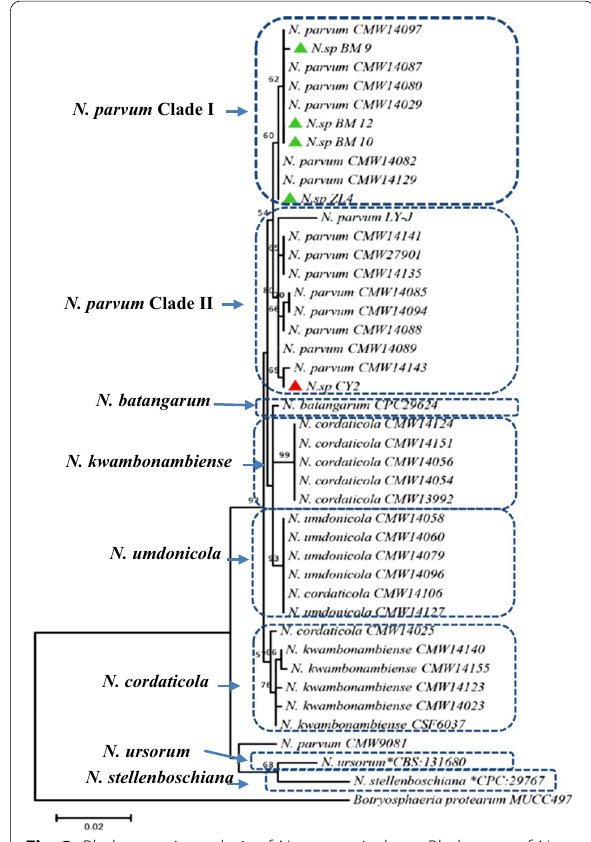
Fig. 3 Phylogenetic analysis of N. parvum isolates. Phylogeny of N. parvum isolates associated with stem canker and twig dieback using MEGA 7.0 with the Maximum Likelihood analysis of the combined sequences consisting of the internal transcribed spacer (ITS), EF-1a , RPB2 , BotF15 and β-tubulin . Analysis was performed with the bootstrap value of 1000 replications, and pairwise deletion option. Values greater than 50% bootstrap are shown on the pictures. Reported sequences from different isolates were downloaded from the GenBank database. Distance scale is shown in the